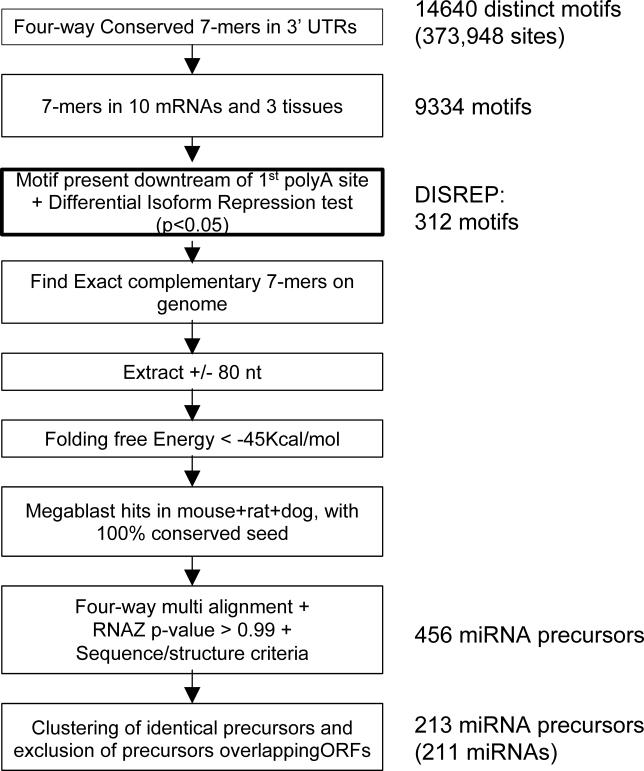
Overall Protocol for the Identification of Regulatory Targets and Subsequent Identification of Cognate miRNAs